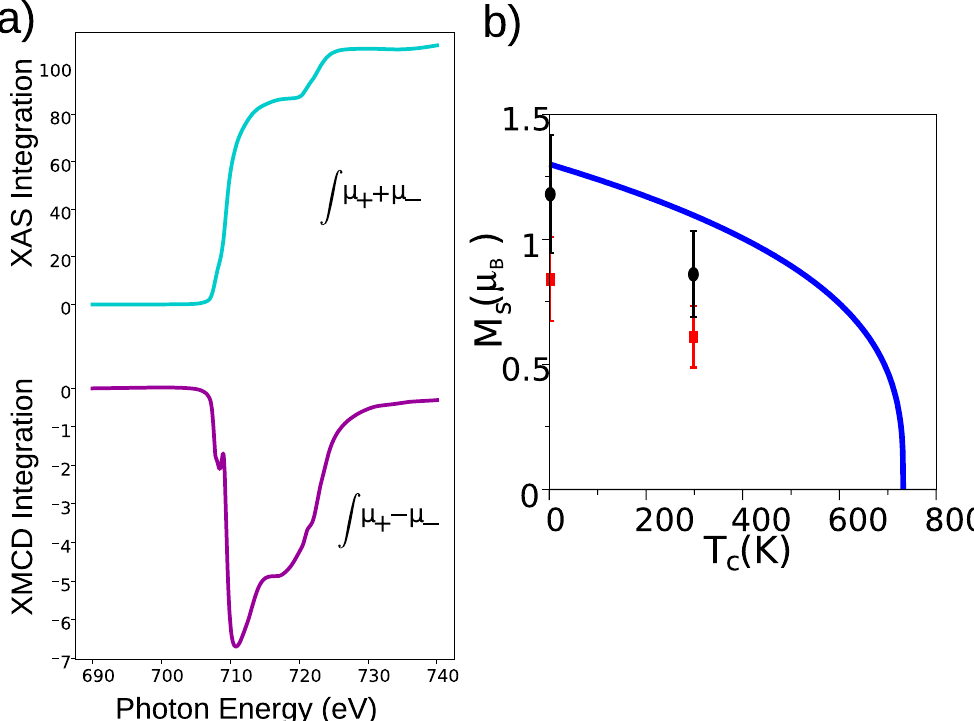
Figure 8. ( a ) Integral of XAS and XMCD used to estimate the orbital and spin magnetic moment of Fe in SFO. ( b ) Total magnetic moment per Fe cation for the platelets (red squares) and from commercial SFO powder (black circles) for two temperatures. We take into account an error in the sum rules of 20% for the calculation of spin orbital moment 64 . The continuous line is the expected change of the magnetization from the bulk magnetic moment with a critical exponent 0.33, which corresponds to a 3D Ising model 46 .